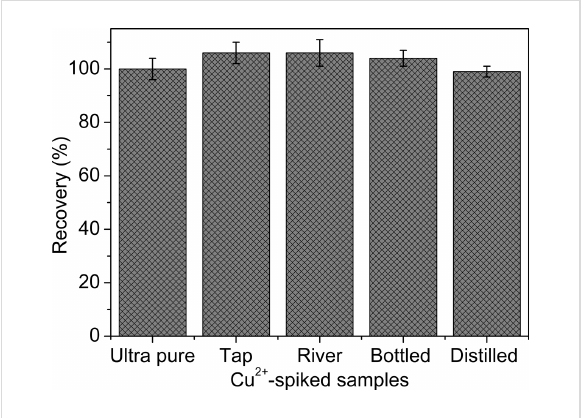
Figure 7: The recoveries of the known amount of Cu 2+ in Cu 2+ -spiked water samples demonstrates reliability of the established sensing